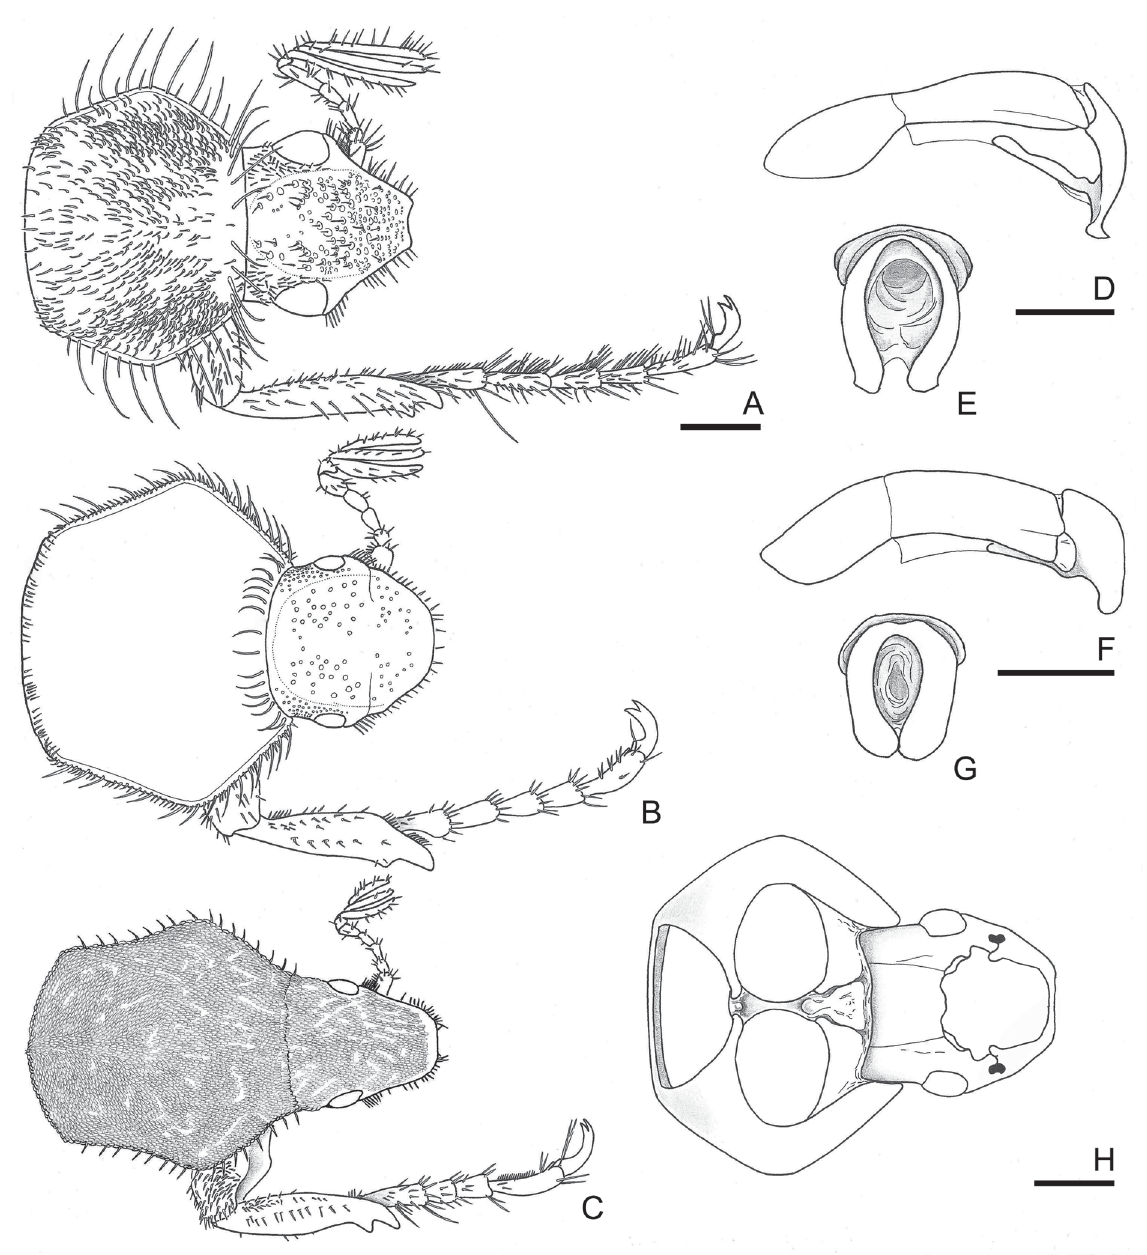
Fig. 11. ♂♂. A−C . Head–prothorax dorsal, tarsus rotated laterally to apex. D−G . Aedeagus (lateral, parameres apex). H . Head−prothorax, ventral. A , D−E . Chariodactylus chacoensis Moser, 1919. B , F−H . Manodactylus gaujoni Moser, 1919. C . Macrodactylus pumilio Burmeister, 1855. Scale bars = 1